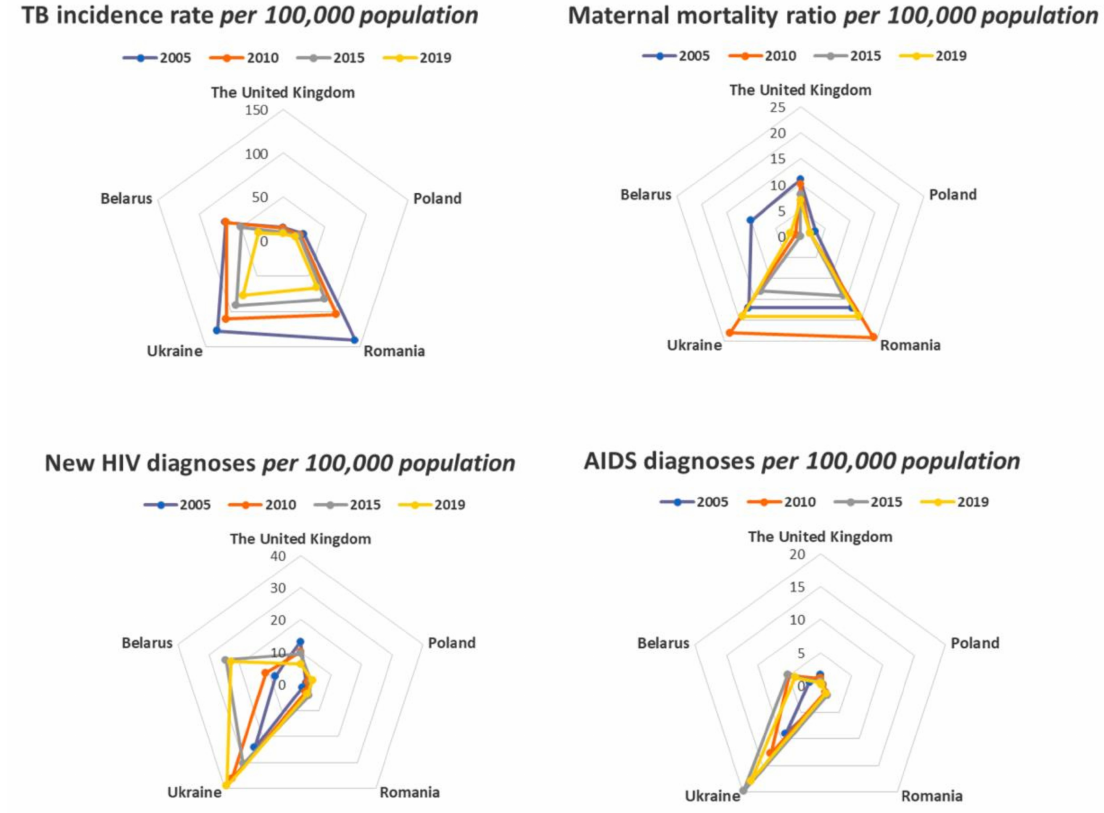
Figure 2. Comparison of the UK and the most mentioned Eastern European countries in the Daily Mail , 2005–2019. Source: Own elaboration based on the WHO data